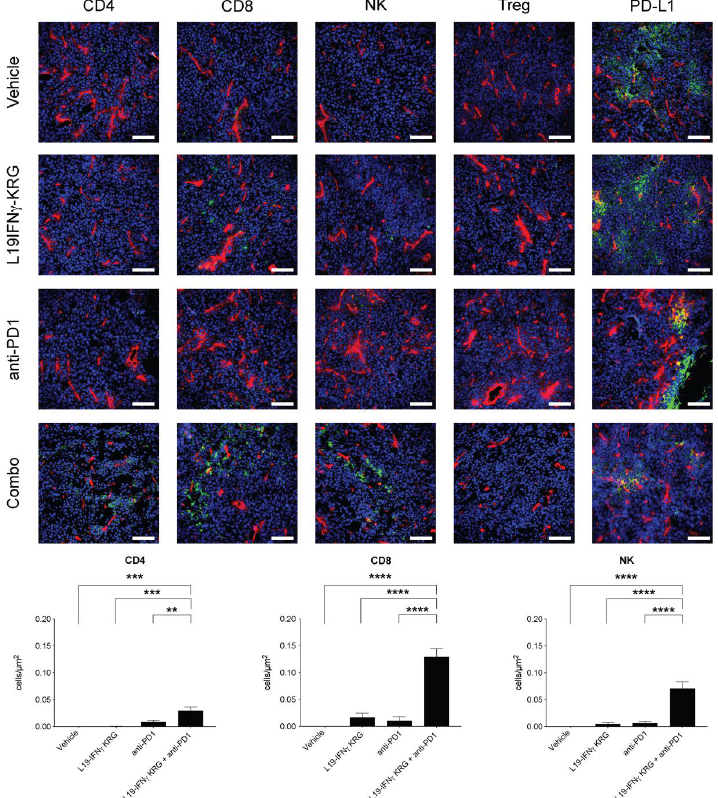
Figure 6. Microscopic analysis and quantification of tumor-infiltrating cells in CT26 tumor sections. Ex vivo immunofluorescence analysis on CT26 colon carcinoma 24 h after the third injection of Vehicle, anti-PD-1 and L19-mIFN γ KRG alone or in combination with 200 μg of anti -PD-1. Markers specific for, CD4 + Tcells (CD4), CD8 + Tcells (CD8), NK cells (NCR1), Tregs (Foxp3), and PD-L1 were used (green). Blood vessels were stained with an anti-CD31 antibody (red). Magnification:10×; scale bars = 100 μm. The panel below shows the quantification of CD4+, CD8+ and NK cells through imaging software. Three distinct slide sections were used for each group and cell subset. Results are expressed as number of cells and normalized on the section area (±SEM). (**: p < 0.01, ***: p < 0.001, ****: p < 0.0001).